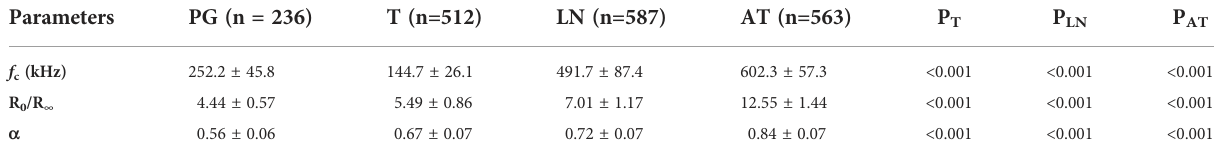
TABLE 2 The parameters of BIS of different tissue. Parameters